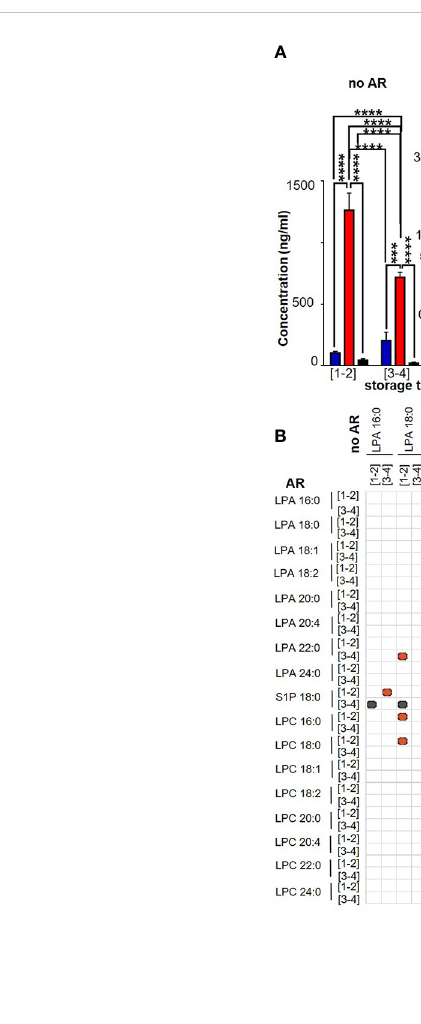
FIGURE 3 Comparison between LPC, LPA and S1P species contained in Single Donor Apheresis during storage with or without an adverse reaction. (A) Graph bar represents the mean ± SEM of the concentration of total LPC (red bar), LPA (blue bar) and S1P (black bar) in SDA-PC without occurrence of AR (no AR, on the left) and with occurrence of AR (on the right). (To refer to n patient, see Table 1). Statistical analysis performed with 2-way ANOVA *p<0.05; ***p<0.0005, ****p<0.0001. (B) Correlation matrix between expressions of LPA, LPC and S1P in SDA-PC with and without AR. Red dots correspond to signi fi cant (p<0.05) and positive correlation with Pearson correlation while the grey/blue dots correspond to signi fi cant (p<0.05) and negative correlation with Pearson correlation. The white box corresponds to insigni fi cant correlation. (C) The pie chart represents the proportion based on the concentration in ng/ml of LPC, LPA and S1P expression during storage of SDA-PC with or without